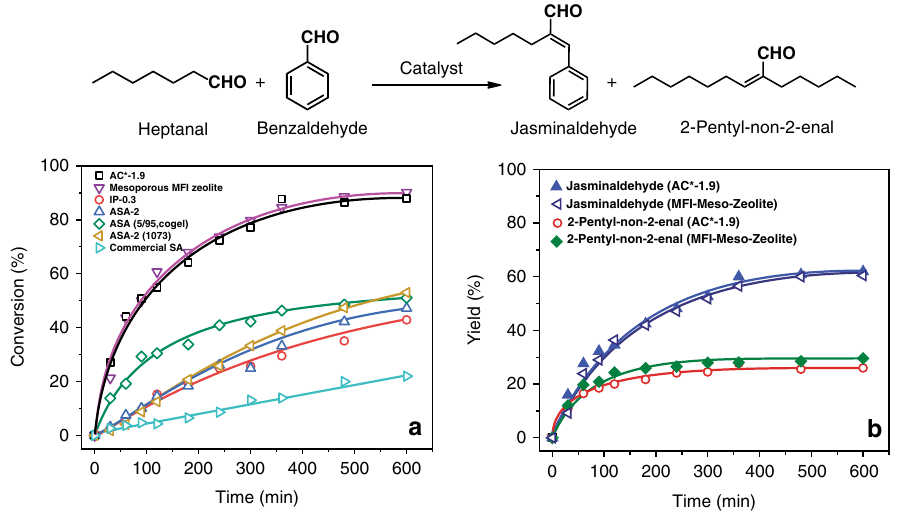
Fig. 4 AAS catalyzed jasminaldehyde synthesis. Jasminaldehyde synthesis using solid acids, a conversion with respect to heptanal, b product yields of best two catalysts, at 125 °C after catalysts activation. Error in the conversion is within ±5% and yield is ±5%.